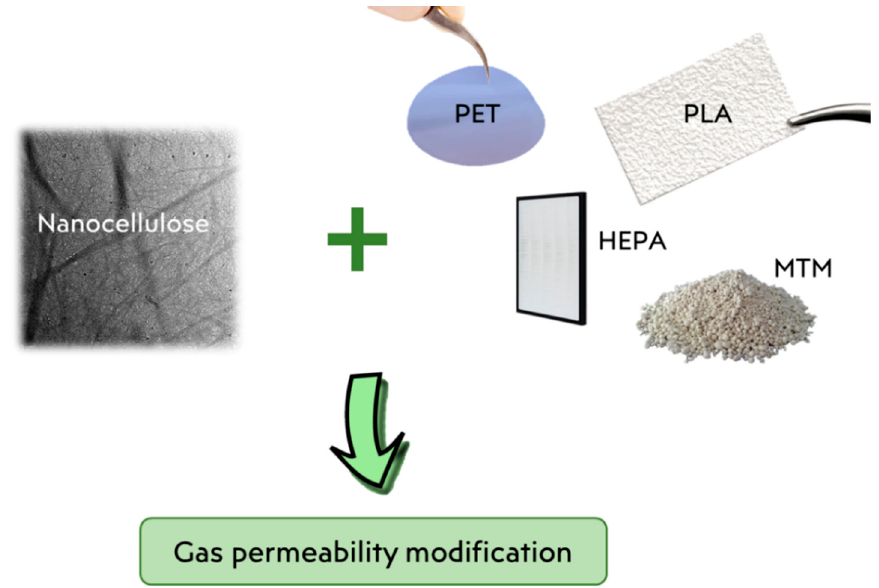
Figure 5. Representation of reinforced systems in which gas permeability is modified by the addi- tion of nanocellulose. of